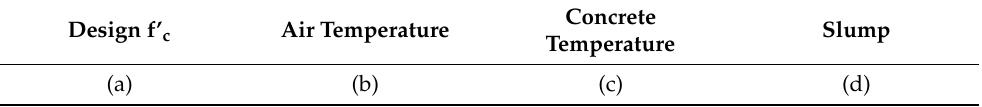
Table 2. Record identifying